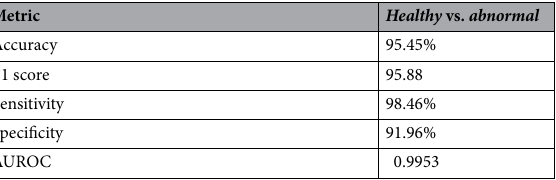
Table 3. Evaluation results of the final model on the test cornea scans dataset when distinguishing only between healthy and abnormal cornea scans. Post laser is treated as abnormal in this case.